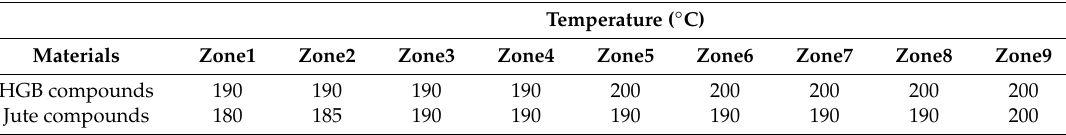
Table 1. Temperature profiles over nine heating zones for hollow glass bubbles (HGBs) and jute compounds.